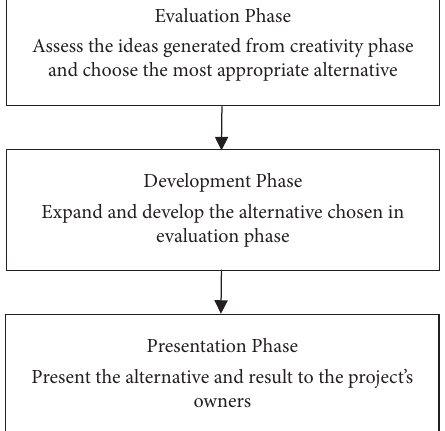
Figure 1: The VE workshop phases/VE job plan